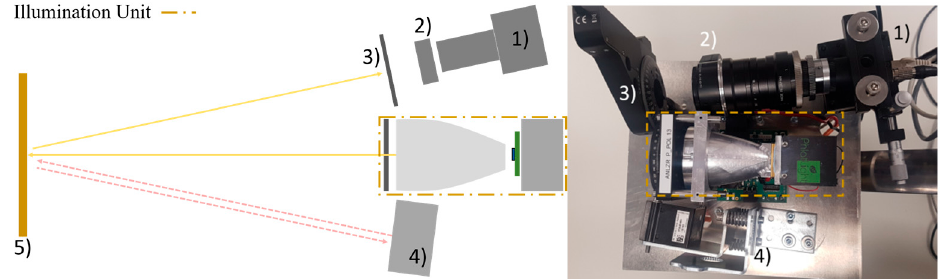
Figure 1. Schematic drawing ( left ) and photograph of the prototype of the non-contact dermatoscope. The imaging unit consists of the camera itself ( 1 ) a liquid lens ( 2 ) in front of the camera lenses and a rotatable polarizer ( 3 ). An infrared laser-based distance measurement device ( 4 ) besides the illumination unit is used to control the shape of the liquid lens and, thus, the focus length. The illumination unit is set up of an ultra-bright white LED source mounted on a radiator and a reflector. The light is polarized by a polarizer mounted in front the reflector. This setup is able to illuminate a target ( 5 ), measure the distance to this target and take images for di ff erent polarization settings.